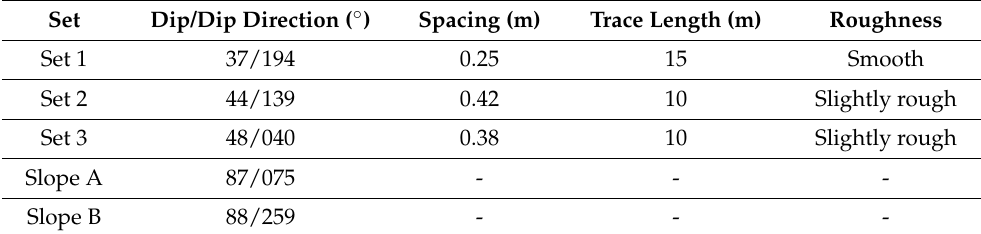
Table 9. Characteristics of the discontinuity sets in Slope ‐ 2 [24] .